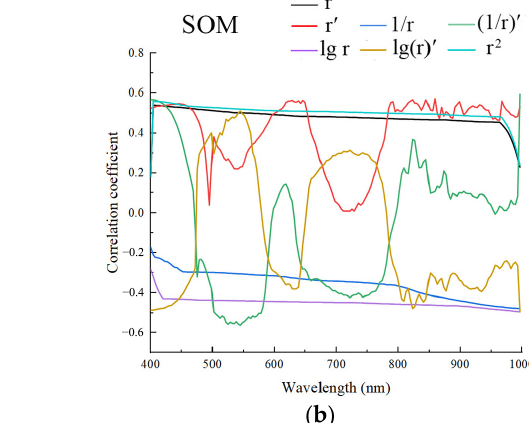
Sensors 2022 , 22 , x FOR PEER REVIEW Figure 3. Correlation of original reflectance and S–G filter denoised reflectance for ( a ) SSC and ( b ) SOM.